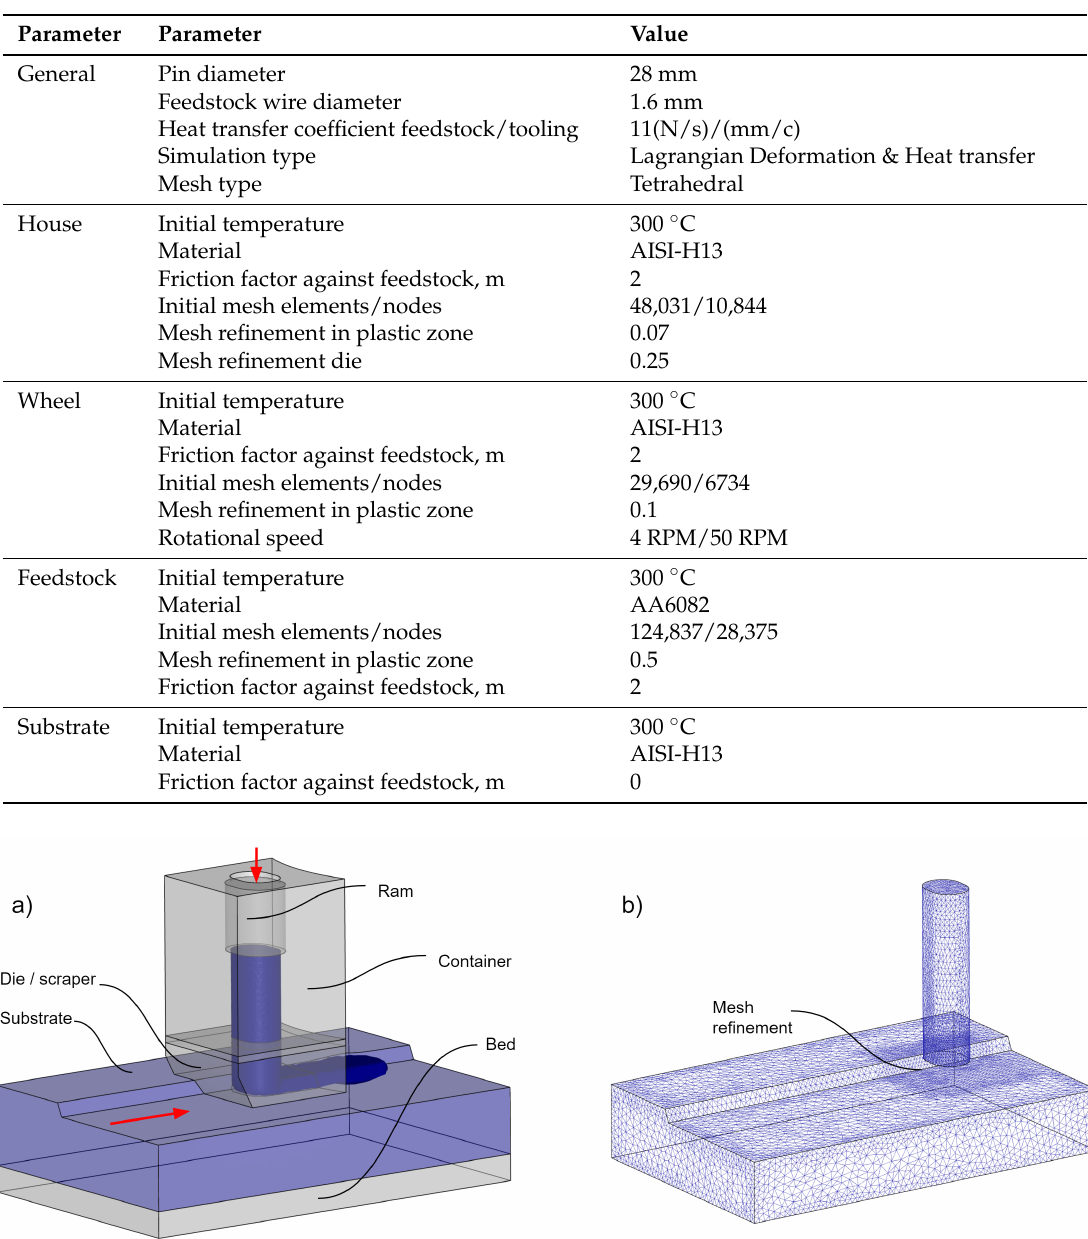
Table 1. Parameters used in finite element method (FEM)-model 1.